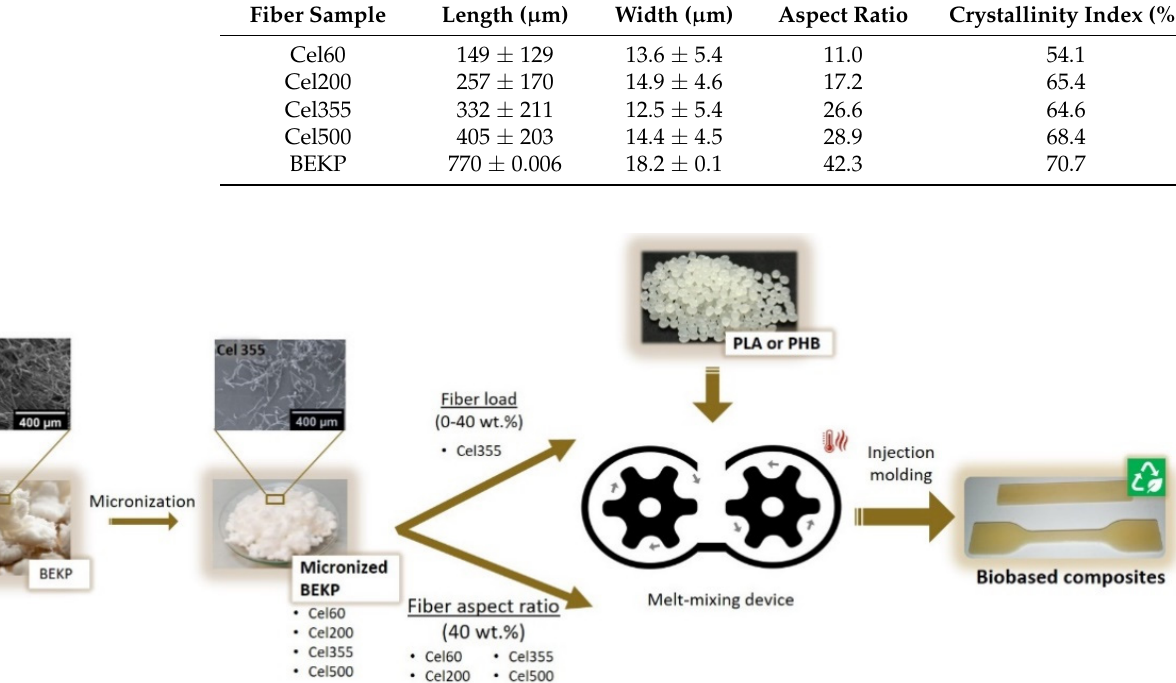
Figure 1. Schematic illustration of the experimental procedure used in the present study. The macroscopic aspect of the composites specimens after the injection molding is shown in Figure 2. The composites with different loads of Cel355 (Figure 2A) are increas- ingly darker with the increment of the fiber load, particularly for the composites with PLA. This behavior can be attributed to the high temperatures used during the processing of these composites, particularly during injection molding (195 ◦ C), which led to some thermal degradation of cellulose. A similar observation was reported by Ozyhar et al. [29] for composites of PLA reinforced with 40 wt.% of wood fibers, where the increase in the composites color intensity was also associated to some thermal degradation of the polysac- charides during processing. Besides the increased color intensity, no visible agglomerates of the fibers could be perceived for composites with different reinforcement loads or for those with 40 wt.% micronized fibers with distinct aspect ratios (Figure 2B), which might indicate that the fibers were homogeneously dispersed in the matrices. The density values of the polymeric matrices agreed with the specification of the products [27,28] (Table S1). As for the composites, as expected, an increase on the fiber load raised the density of the composite, given the superior density of the fibers [30] in comparison with the ther- moplastic polymers used in the present work. Conversely, the density of the composites with fibers having different aspect ratios remained relatively unchanged (Table S1). Then, the morphology, mechanical properties, water-uptake capacity, flowability, and thermal stability of all the composites were